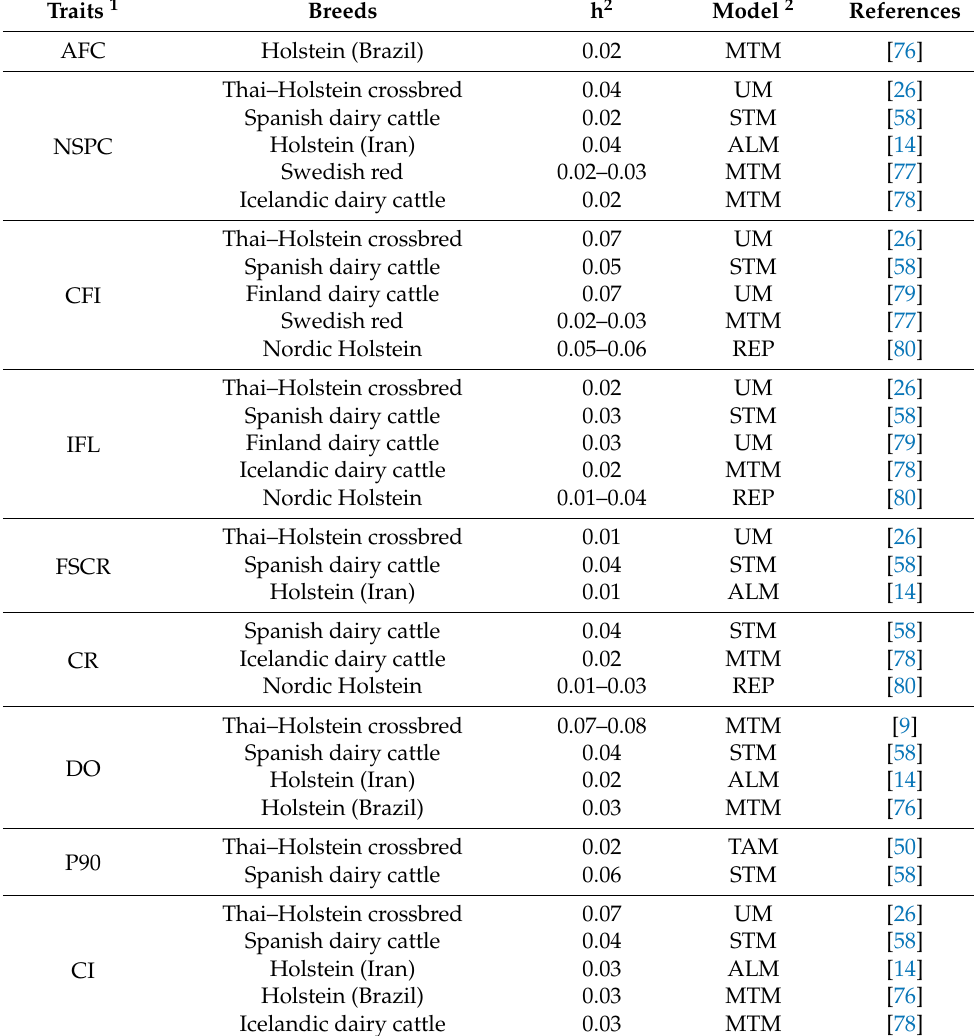
Table 1. Heritability (h 2 ) of reproductive traits in dairy